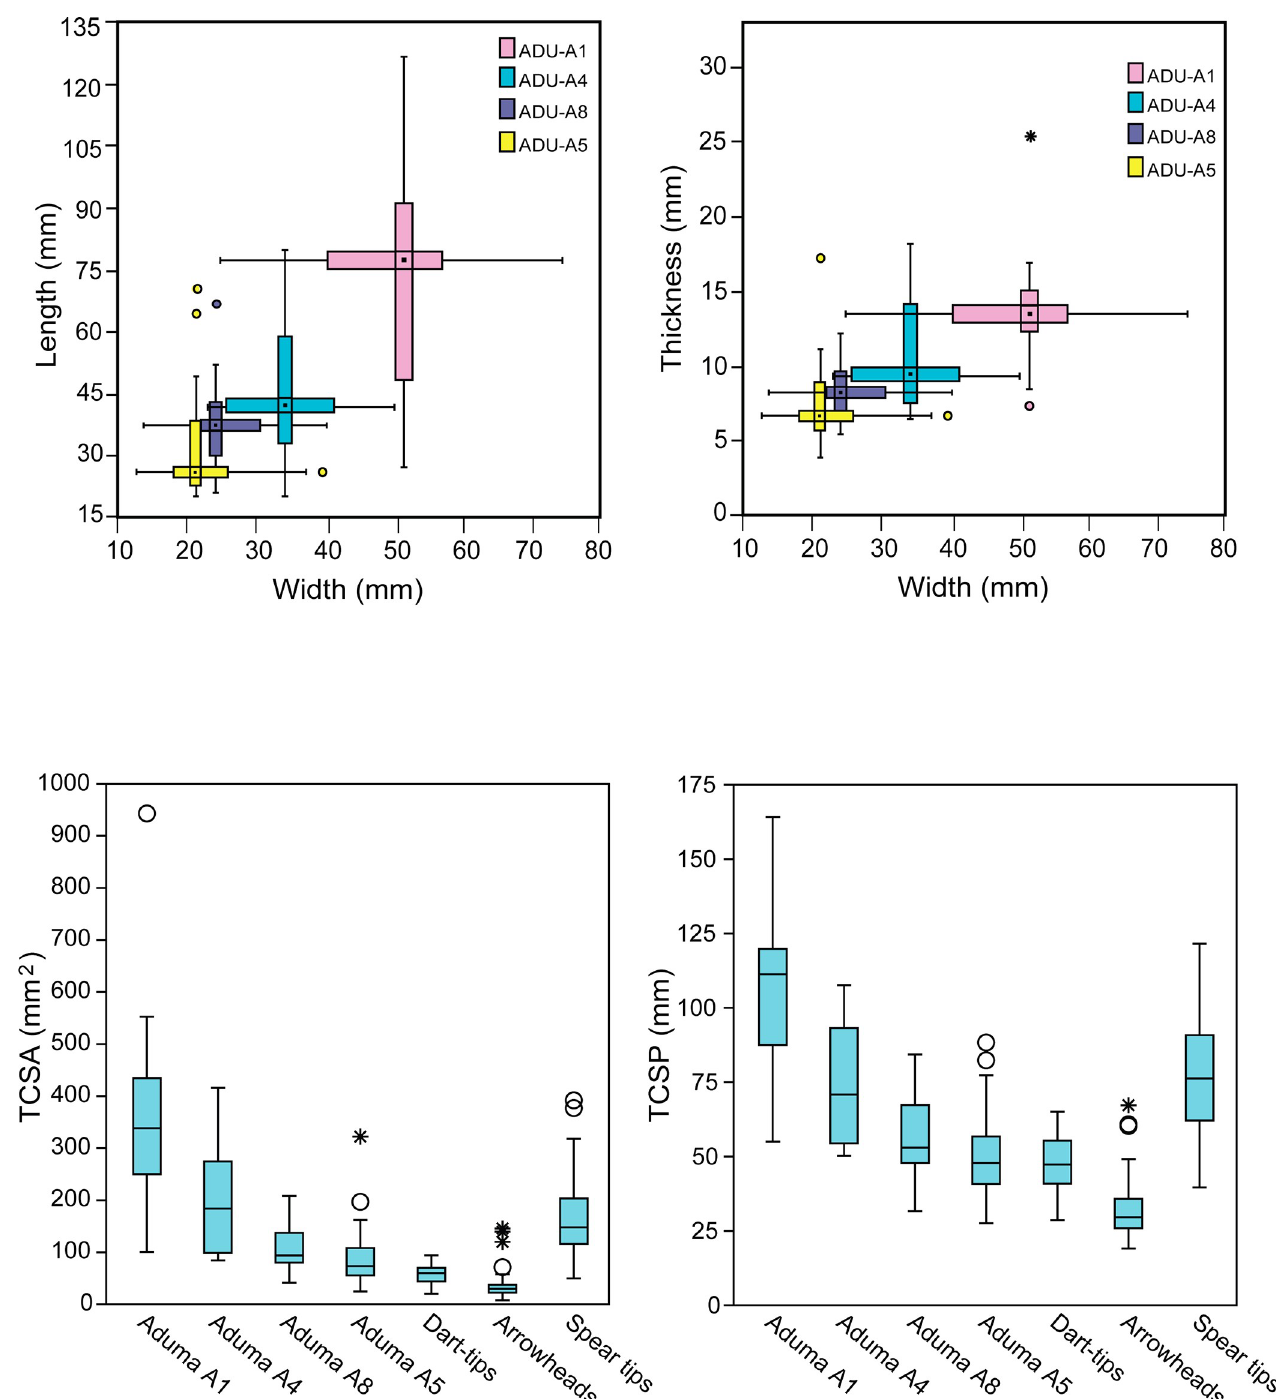
Fig 3. Box-plots of Aduma lithic point dimensions (top); Tip cross-sectional area (TCSA), and perimeter (TCSP) of Aduma and ethnographic point assemblages